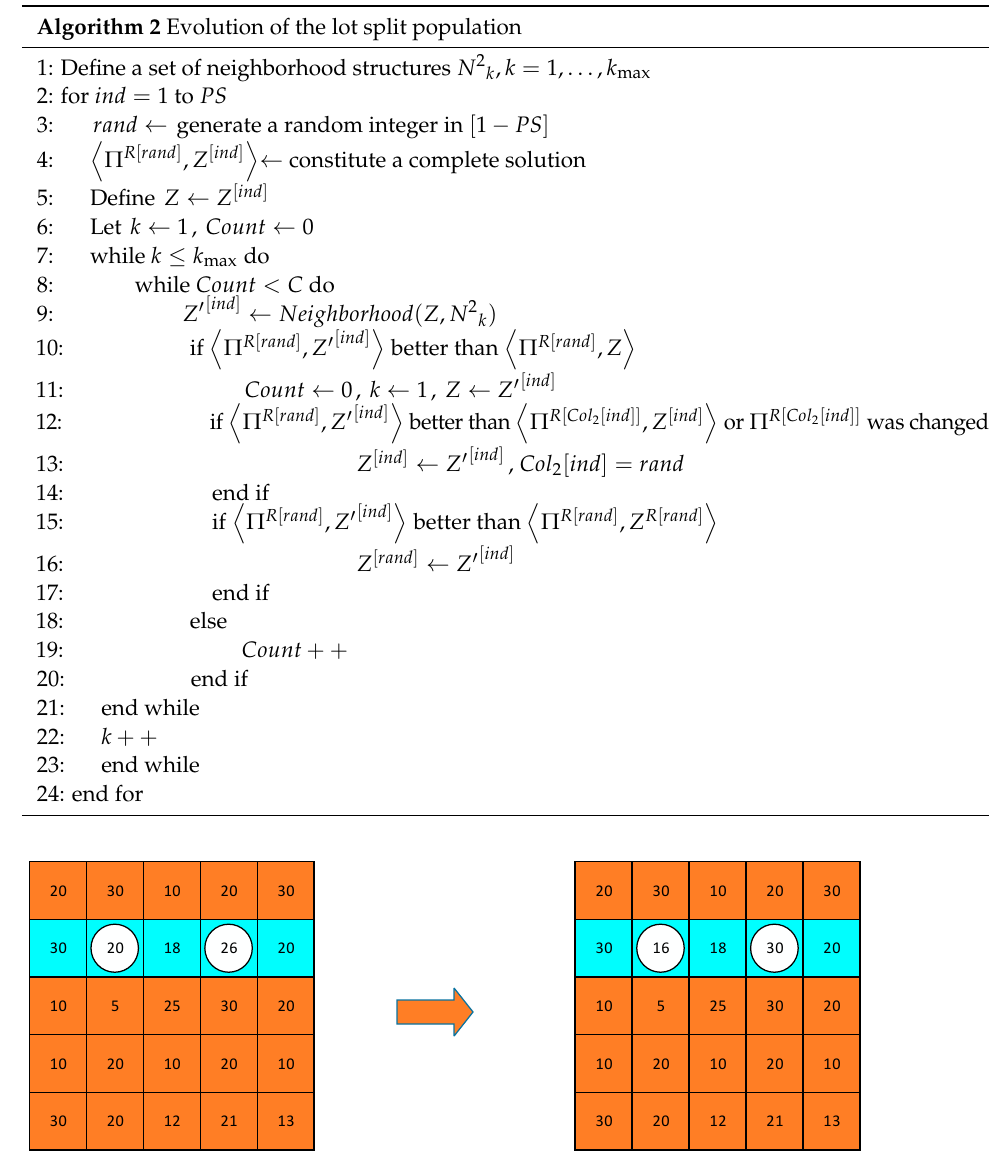
Figure 5. Illustrations of the lot split mutation. Algorithm 2 Evolution of the lot split population